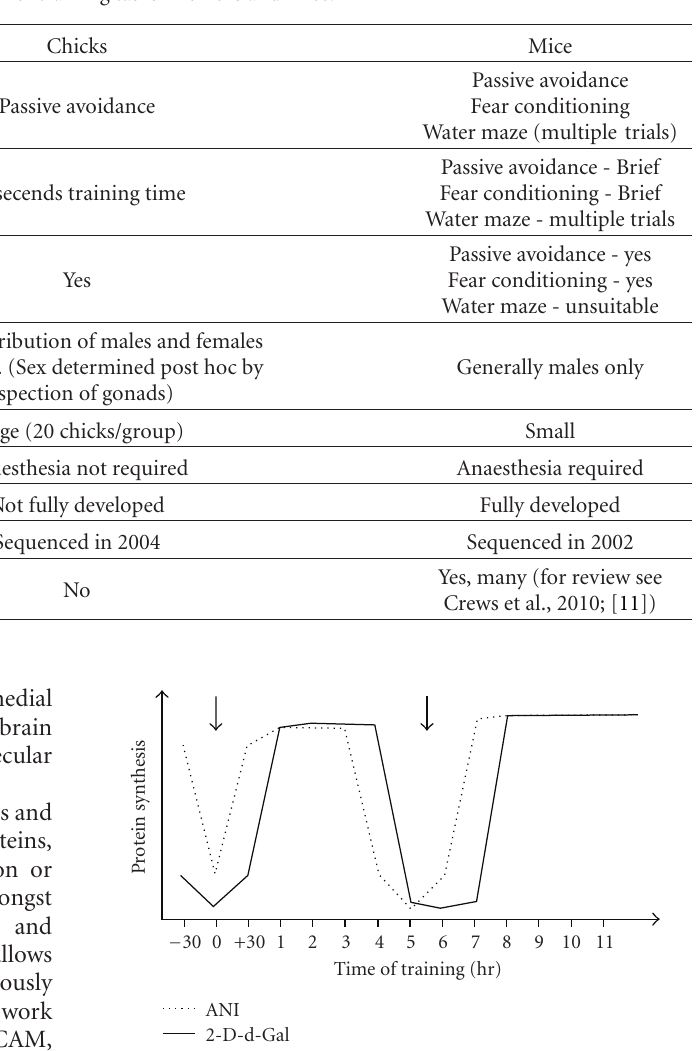
Table 1: Comparison of training tasks in chicks and mice.